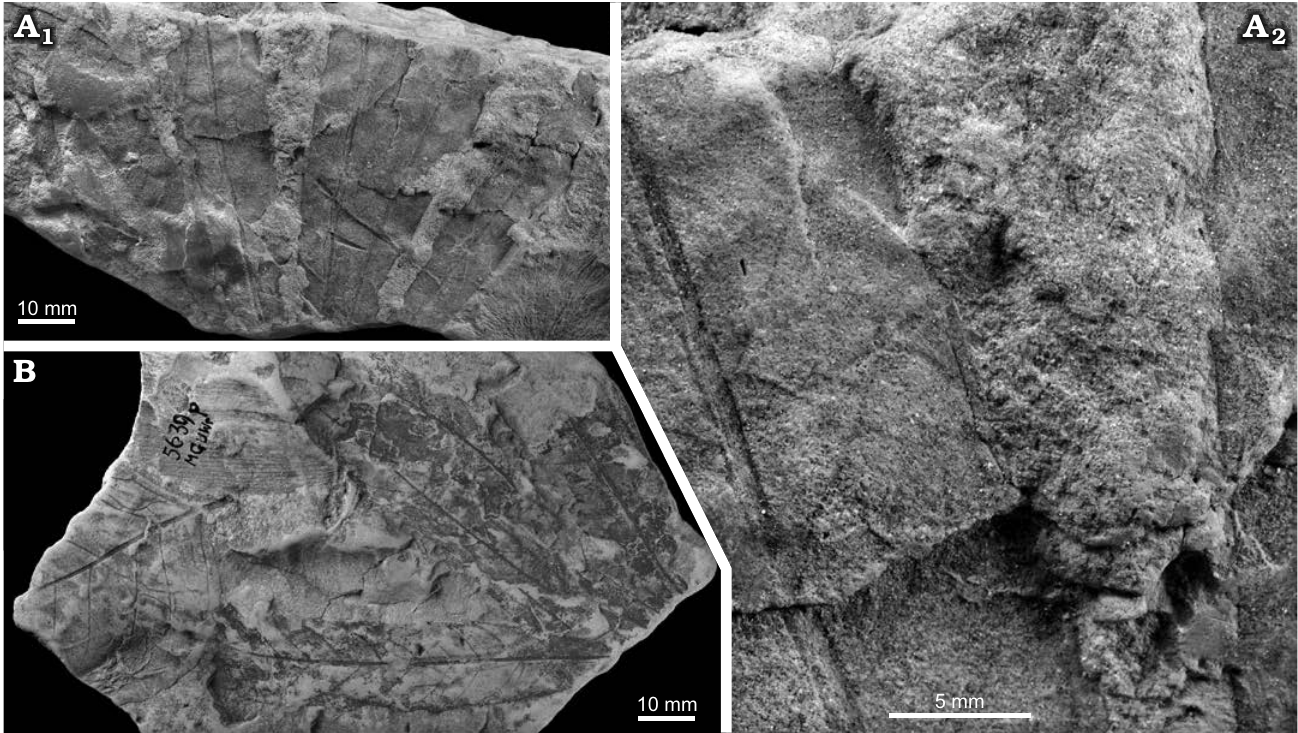
Fig. 11. Taphonomy of the eudicot angiosperm Dewalquea insignis Hosius and von der Marck, 1880 from the North Sudetic Basin, Lower Silesia, Poland. A . Fragmentary compound leaf MB.Pb.2008/325.1, Bolesławiec, Assemblage 8 (Santonian); general view (A 1 ) and enlargement of fragments of two leaf- lets to show venation and teeth (A 2 ). B . Accumulation of leaflets (presumably from the same compound leaf) MGUWr 5639p accompanied by Salicites ? sp. and unidentified vegetal remains, Ulina?, Assemblage 8? (Santonian?).